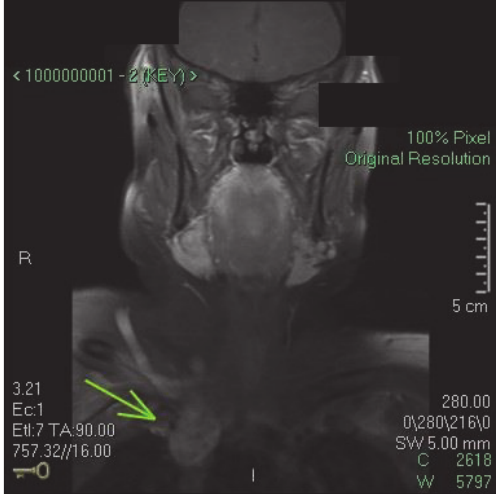
Figure 1: Coronal section from the preoperative magnetic reso- nance images showing a superior vena cava mass, presumed to be lymph nodes abutting the vein.